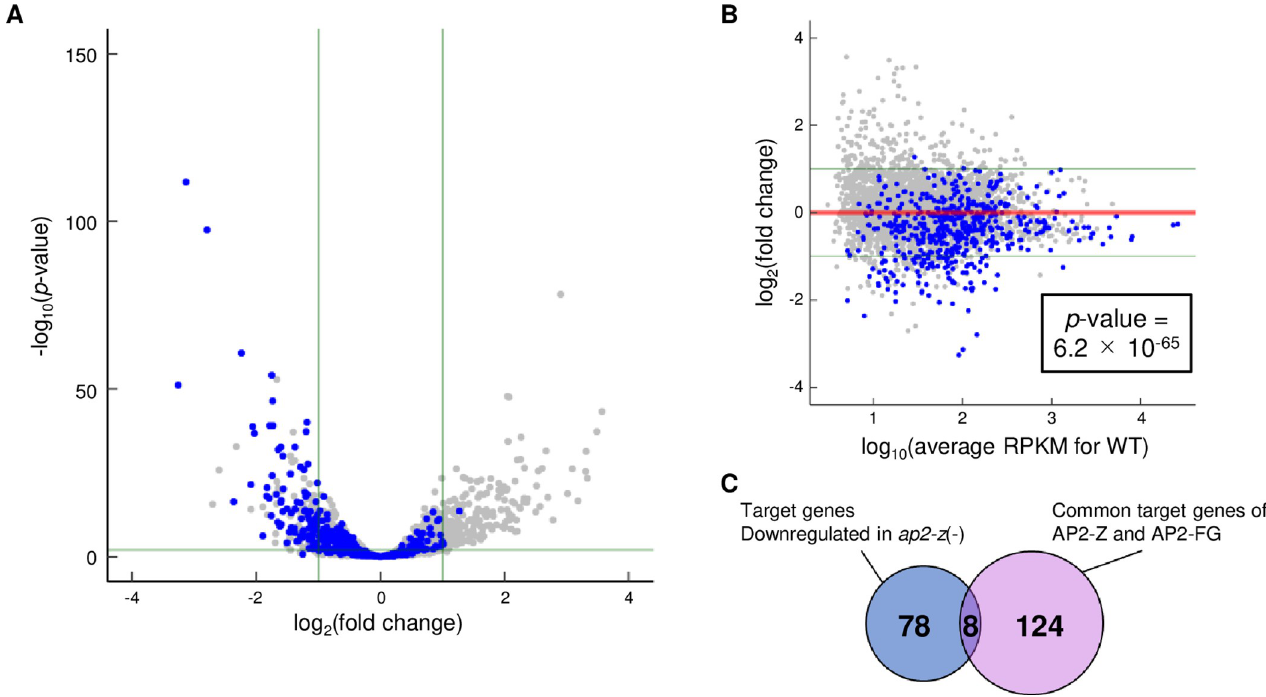
Fig 7. Differential expression analysis between WT and ap2-z (-) at 6 hoc. (A) Volcano plot showing differential expression analysis between WT and ap2-z (-) at 6 hoc. Blue dots represent the target genes of AP2-Z. Green horizontal line indicates a p -value of 0.05. Two vertical lines indicate log 2 (fold change) values of 1 and − 1. The plot for ap2-z is omitted from the graph [log 2 (fold change) = − 4.5, p -value adj = 4.9 × 10 − 300 ]. (B) MA plot showing differential expression analysis between WT and ap2-z (-) at 6 hoc. The p -value in the box represents a statistically significant difference between the mean values of log 2 (fold change) for AP2-Z targets and the other genes. Two green lines indicate log 2 (fold change) values of 1 and − 1, and the red line indicates a log 2 (fold change) of 0. (C) Venn diagram showing the overlap between AP2-Z targets downregulated in ap2-z (-) and the common targets of AP2-Z and AP2-FG.